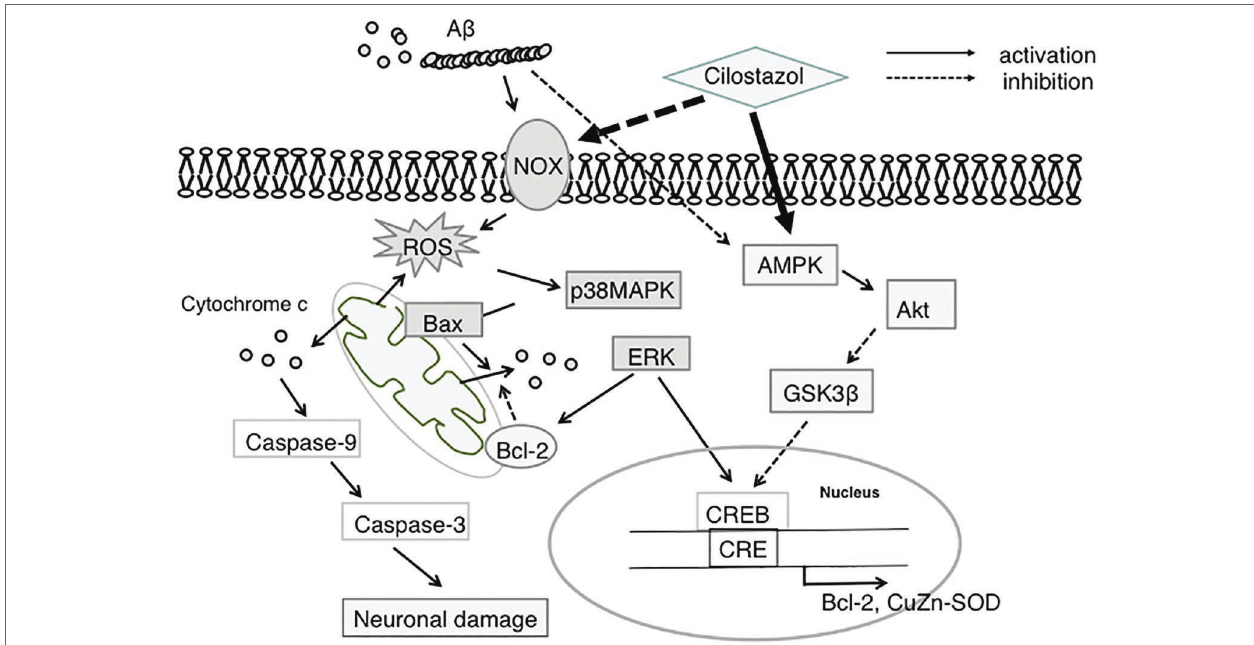
FIGURE 1 | Proposed neuroprotective mechanism of CSZ against A β -induced neurodegeneration. This scheme shows that CSZ suppresses A β -induced neurotoxicity via ROS-activated p38MAPK and AMPK/CREB pathways. NOX, NADPH oxidase; ROS, reactive oxygen species; p38MAPK, p38 mitogen-activated protein kinase; ERK, extracellular regulated kinase; AMPK, 5 ′ -adenosine monophosphate (AMP)-activated protein kinase; GSK3 β , glycogen synthase kinase 3 β ; CREB, cAMP-responsive element-binding protein; SOD, superoxide